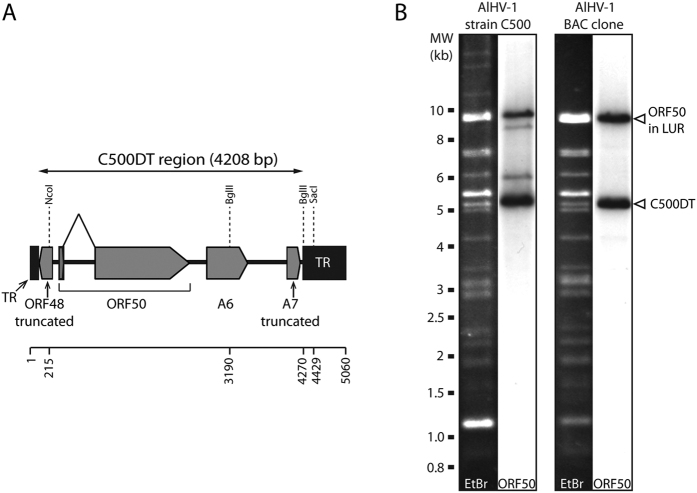
Presence of a duplicated region in parental strain C500 and the BAC clone.(A) Diagram of C500DT showing the duplicated region from LUR containing a part of ORF48, ORF50 and A6 in their entirety and a part of A7, inserted into a copy of TR. Nucleotide positions are indicated. (B) Southern blot of SacI-digested DNA showing the presence of the duplicated region in the BAC clone and the parental virus. The ORF50 probe was produced by PCR using primers C500-1 and C500-224. EtBr indicates ethidium bromide-stained lanes prior to blotting. The entire lanes analysed by Southern blotting are shown.